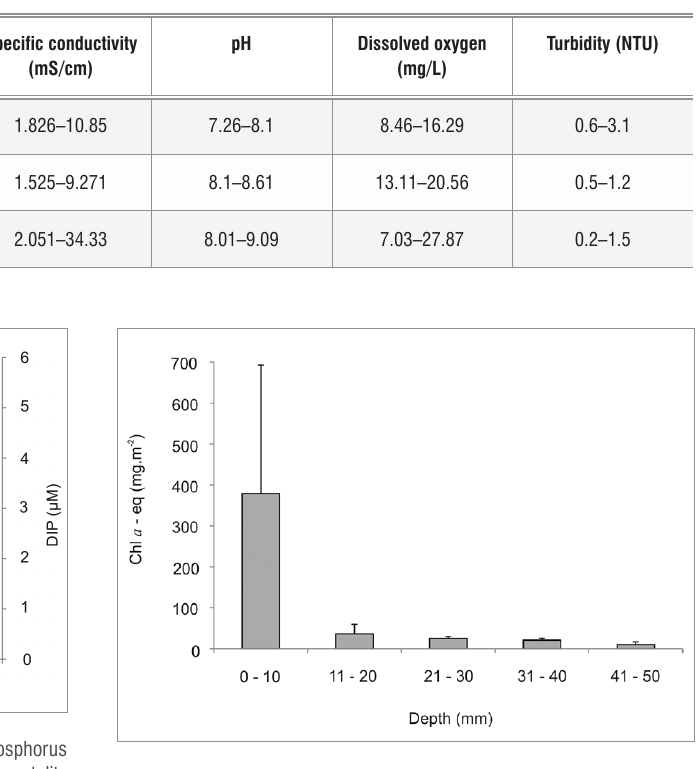
Figure 5: Average chlorophyll- a profile of cores (+SD) taken at strom- atolite Pools A–C during October 2013.